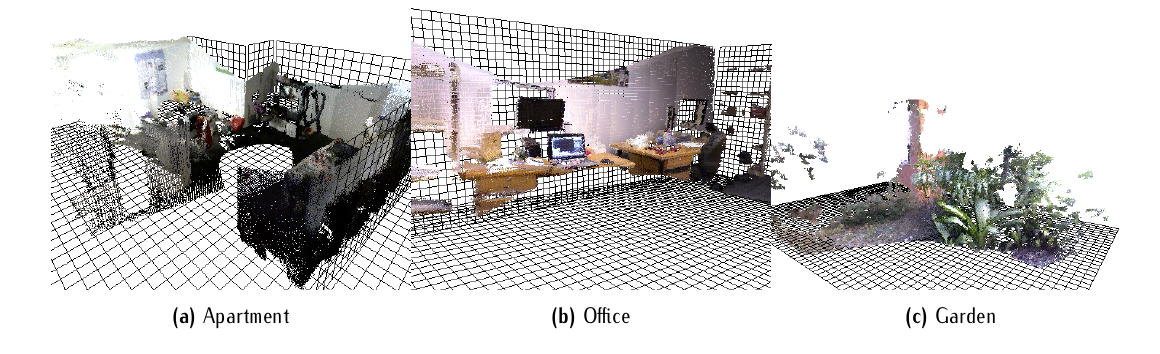
Figure 4. Reconstructed Scenes.